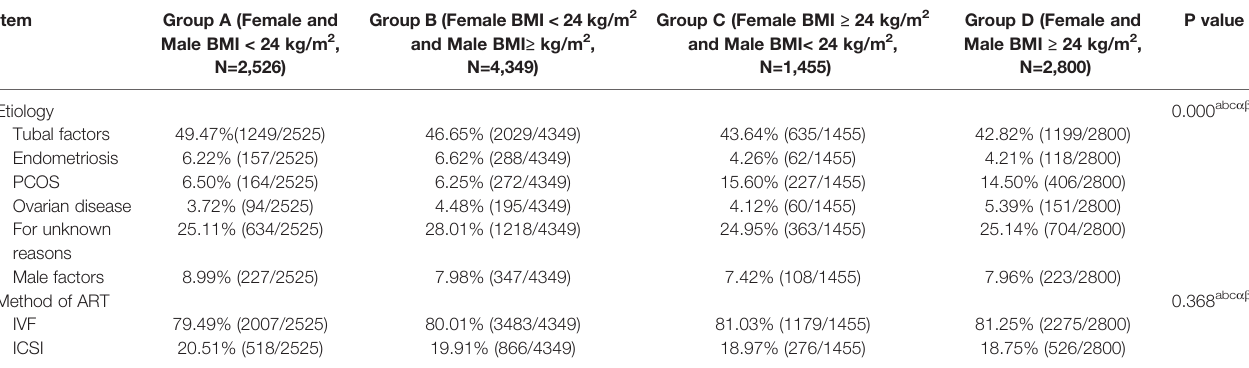
b Group A vs Group C. c Group A vs Group D. a Group B vs Group C. b Group B vs Group D.